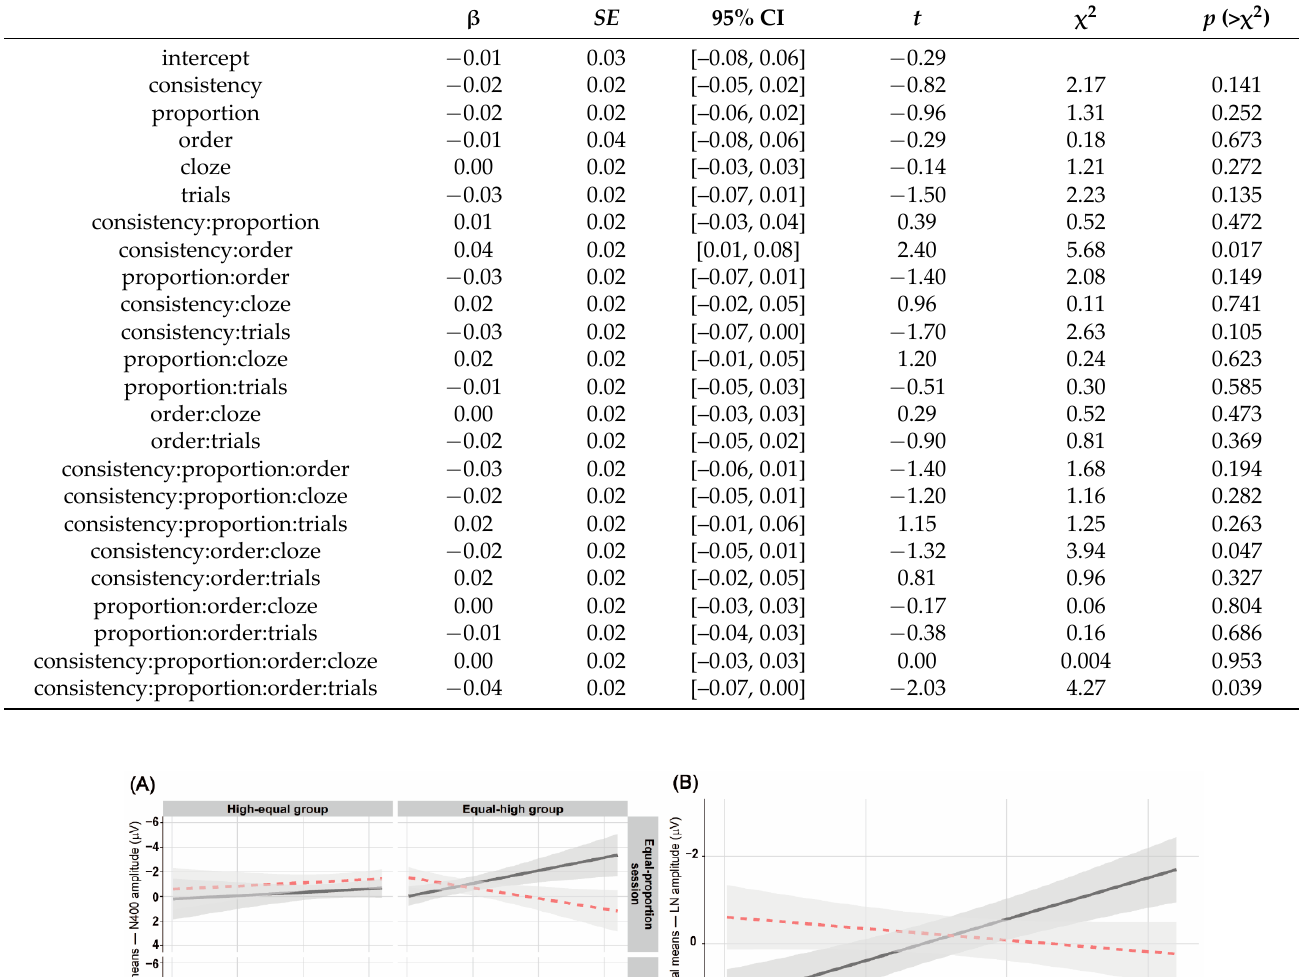
Table 4. Estimates of fixed effects and analysis of deviance (Type II Wald chi‑square tests) for the N400 (300–600 ms) time window for models that included trials as a predictor.